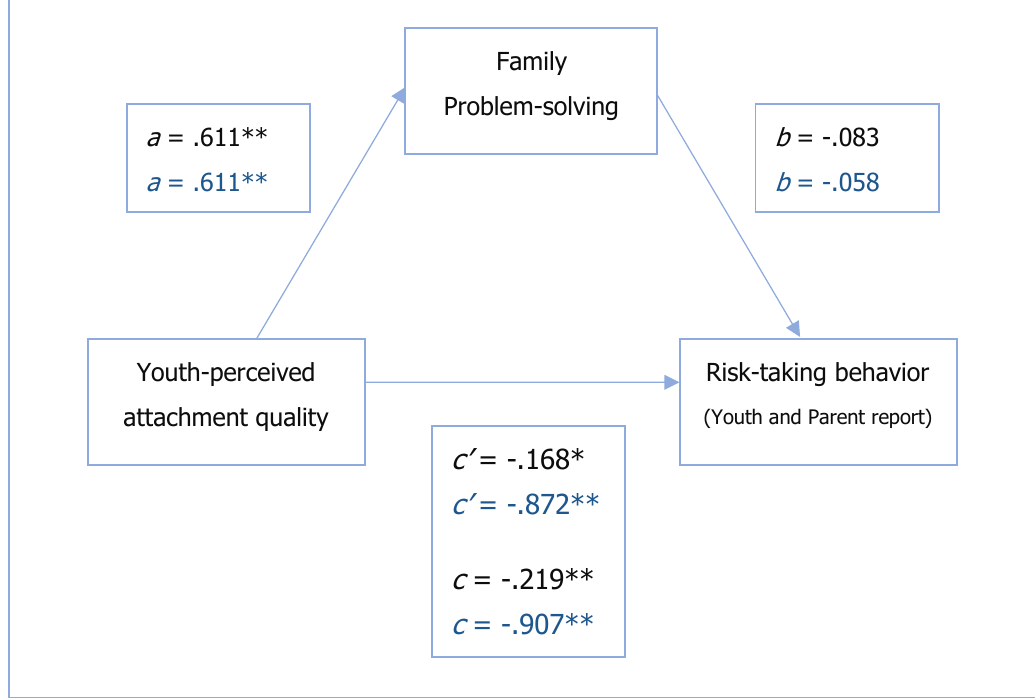
Figure 1. Mediation Model for the Effects of Attachment Quality and Family Problem- Solving Ability on Adolescent Risk-Taking